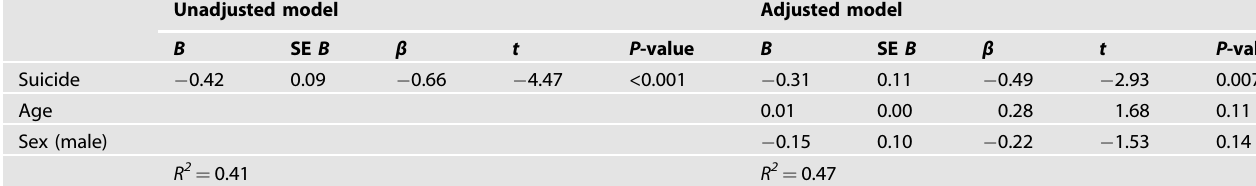
Table 3. Estimated result of ANCOVA comparing aqueous humor lithium levels in suicides and non-suicides. Unadjusted